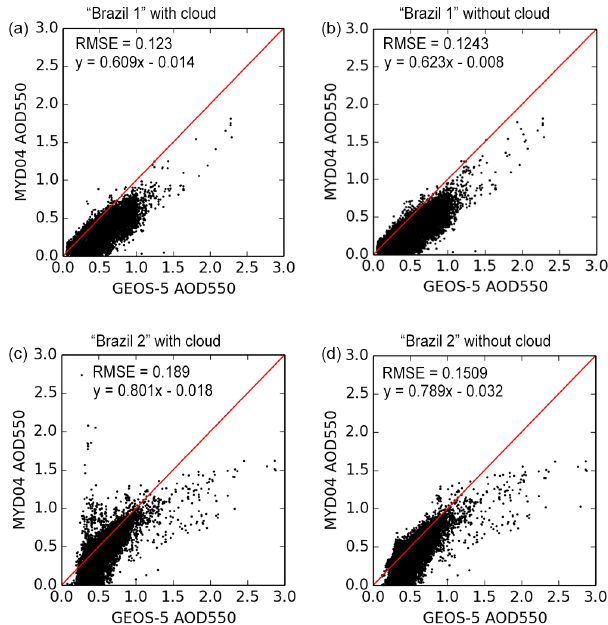
Figure 2. MYD04 retrieval of 550nm aerosol optical depth vs. ground “truth” of GEOS-5 550nm aerosol optical depth. Panel (a) shows the scatterplot for retrieval from simulation in Fig. 1c and panel (b) shows retrieval from simulation in Fig. 1d for Brazil 1 case. Panels (c) and (d) show same information for Brazil 2 case.